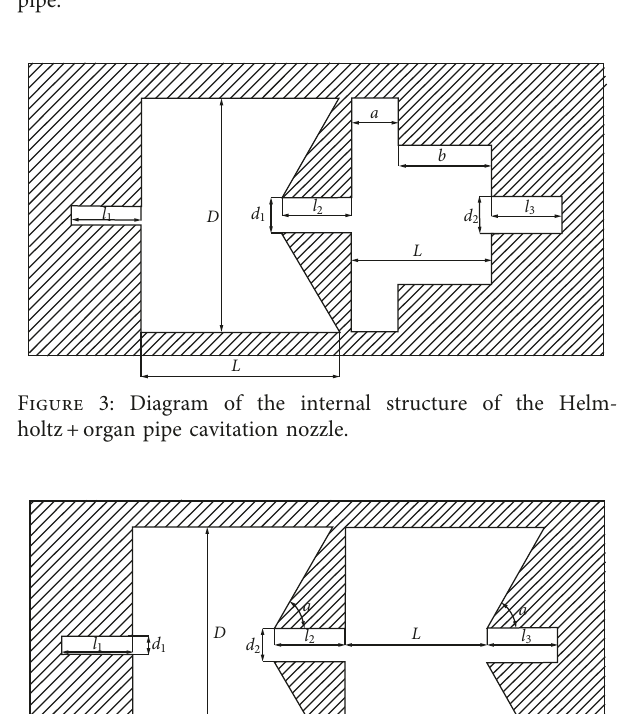
Figure 2: The traditional Helmholtz and organ pipe self-excited oscillating pulsed nozzles’ cutaway view. (a) Helmholtz nozzle. (b) Organ pipe.